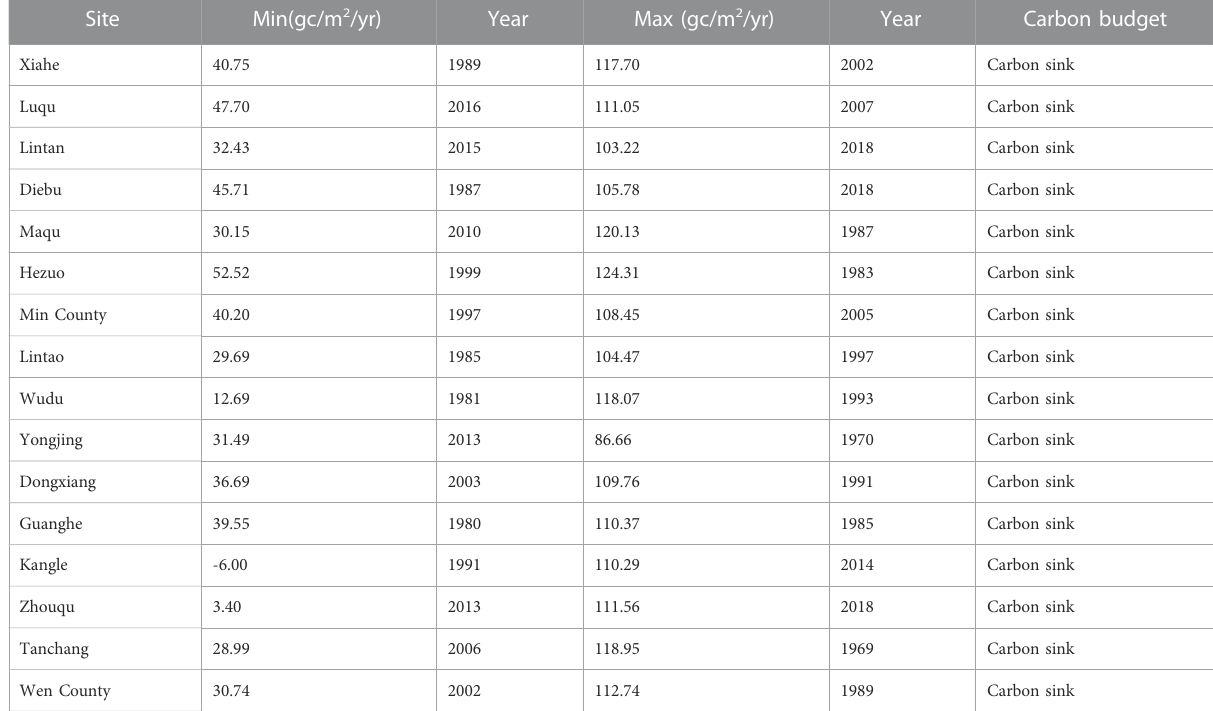
TABLE 1 Carbon budget of each district in the Gannan Alpine Meadow,